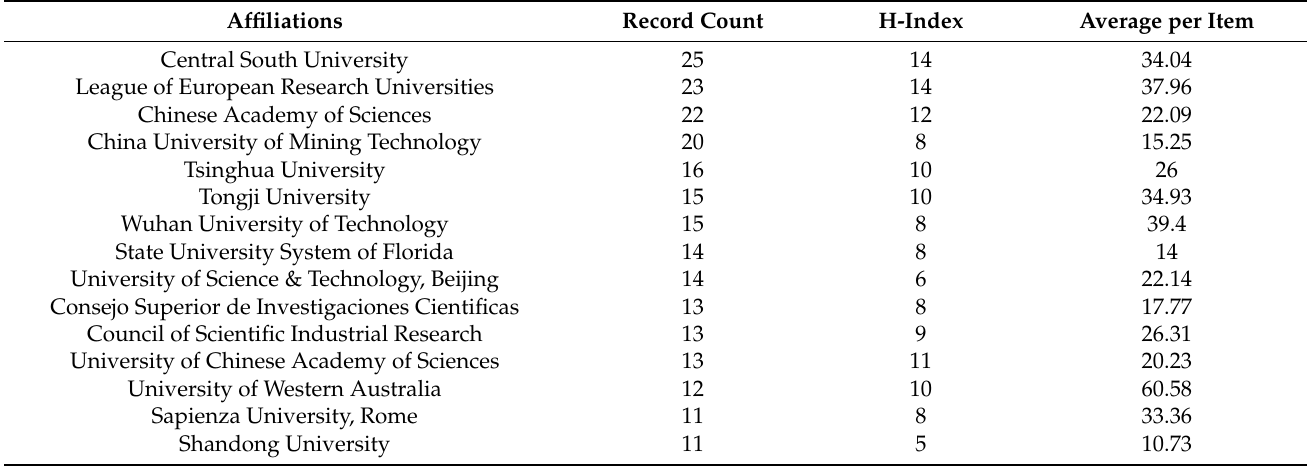
Table 2. Statistics of the top fifteen most productive institutions.